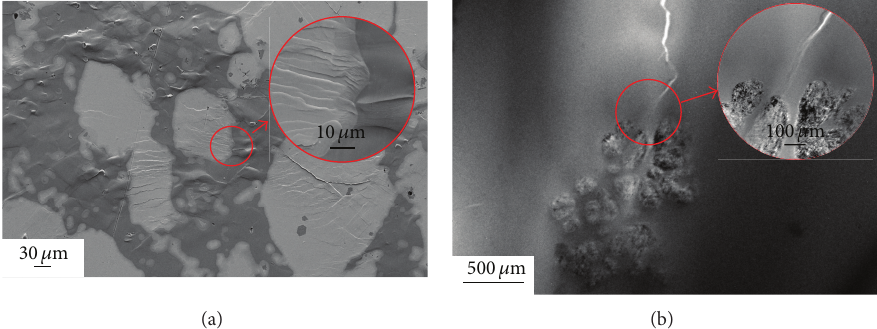
Figure 3: (a) SEM micrographs of the lateral surface of fractured sample showing that the crystalline phase restrains the shear band motion and gives rise to multiple shear bands in the glassy phase; (b) TEM micrographs of deformed samples showing that the precipitated crystalline phase inhibits the microcrack